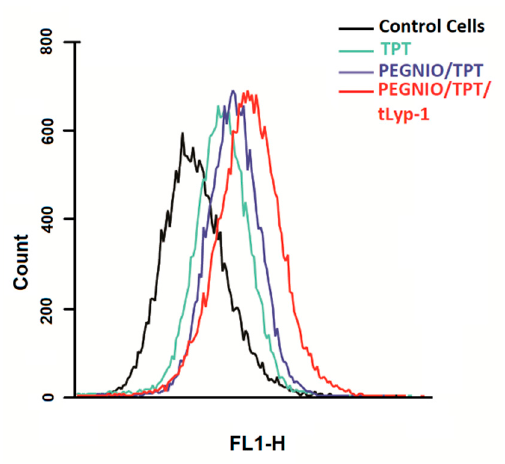
Figure 3. Flow cytometric measurement of TPT uptake by U87 cells after incubating with free TPT, PEGNIO/TPT, and PEGNIO/TPT/tLyp-1.